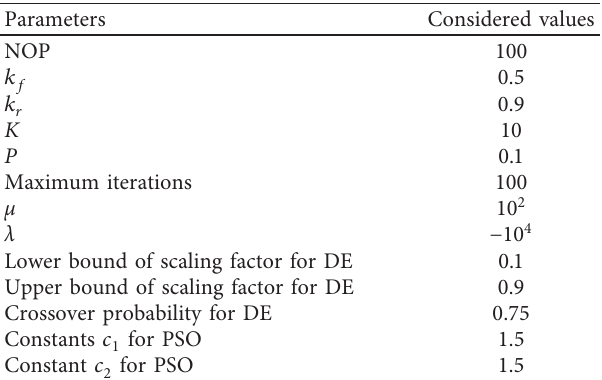
Table 3: Numerical values of